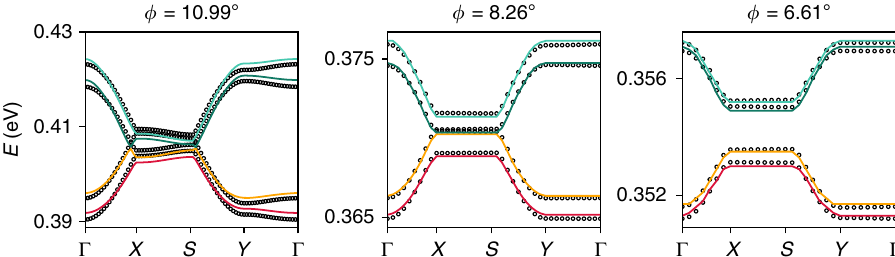
Fig. 5 Ab initio band structure obtained with the GGA functionals and including van der Waals corrections (lines), as well as a next-nearest neighbor Hubbard model fi t (circles) to the dispersion for different angles. This allows to extract nearest-neighbor hopping amplitudes along the x direction ( t ? ), along the y direction ( t k ), the next-nearest hopping along the diagonal ( t D ), as well as the onsite potentials ϵ i . Clearly the dispersion along the x direction vanishes as we approach smaller angles. The results of the fi t are summarized in Table 2.